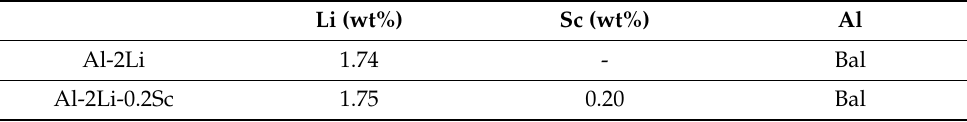
Table 1. Chemical compositions of the prepared Al alloys (mass